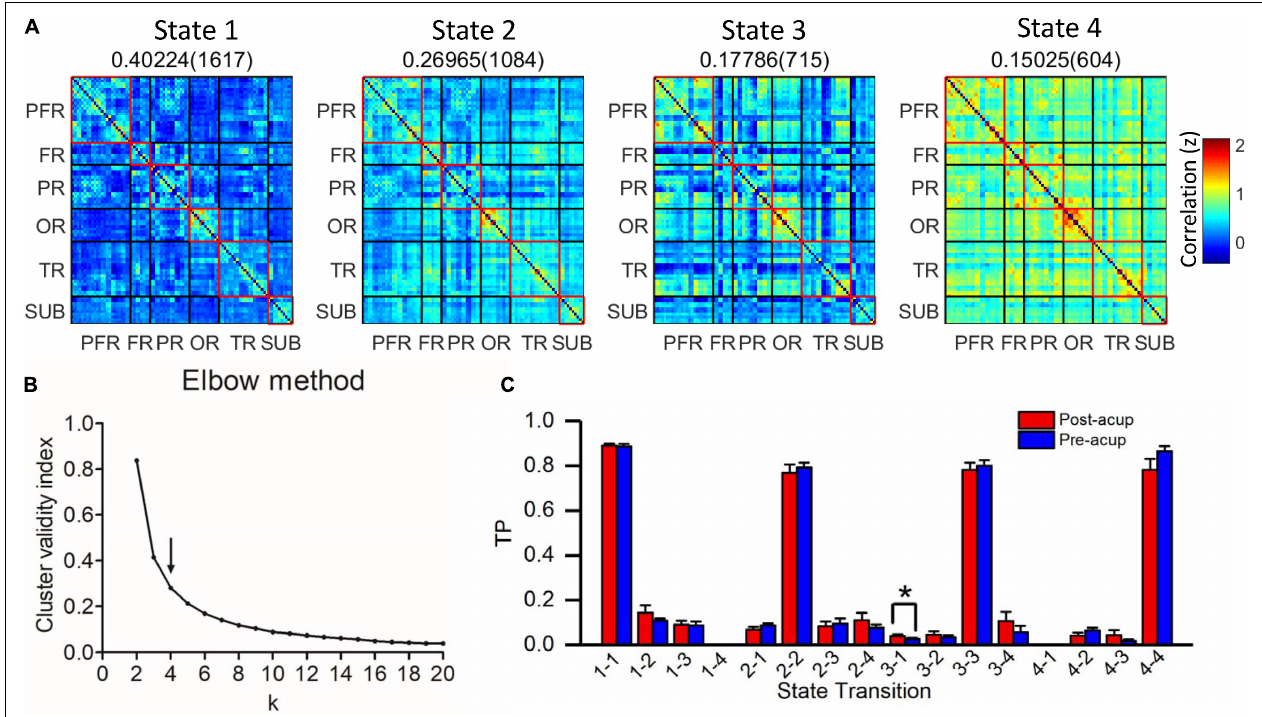
FIGURE 7 | Clustering analysis of four states in chronic tinnitus patients before and after acupuncture. (A) Four states (centroids) from clustering analysis. The total number (in brackets) and proportion of occurrences are listed above each state. (B) Elbow criterion. The arrow represents the optimal k value. k , the number of clusters; Cluster validity index, calculating as the ratio of within-cluster distance to between-cluster distance. (C) Comparison of TP within chronic tinnitus patients before and after acupuncture. FR, other regions of frontal lobe; PR, parietal regions; OR, occipital regions; PFR, prefrontal regions; SUB, subcortex regions; TP, transition probability; TR, temporal regions. * P <